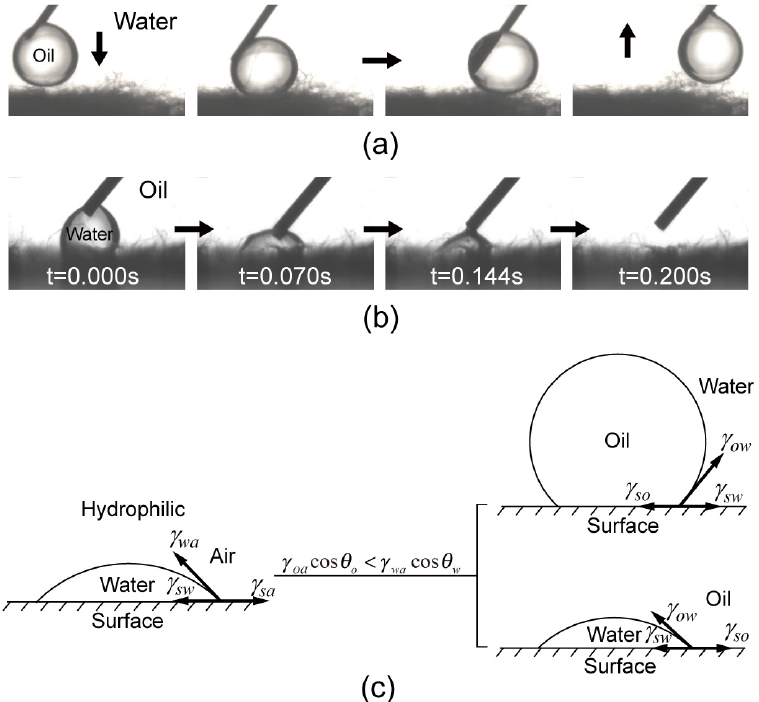
Figure 3. The laser scanning confocal morphology of the ( a ) pristine ( b ) prewashed cotton and ( c ) CTS-coated cotton.